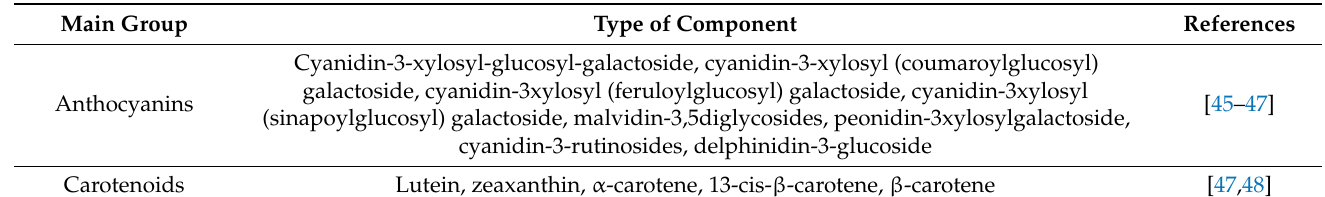
Table 2. Bioactive components of the purple